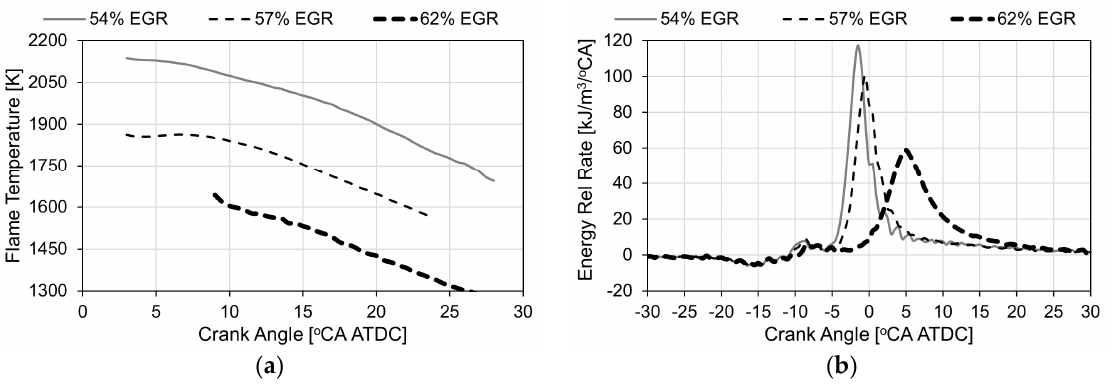
Figure 5. ( a ) Flame temperature and ( b ) energy release rate during a minor change in the EGR rate at a fixed SOI of − 21 °CA ATDC. Note different x -axis scales to focus on the flame temperature ( a ) and provide the full combustion profile ( b ).